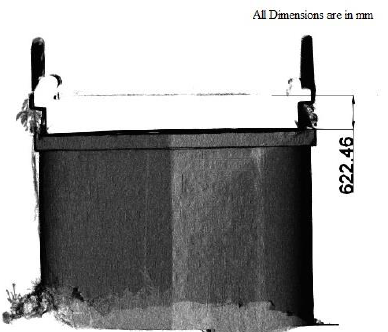
Figure 16: Bridge deck thickness of Beam Bridge The Beam Bridge deck thickness obtained is 622.46 mm.